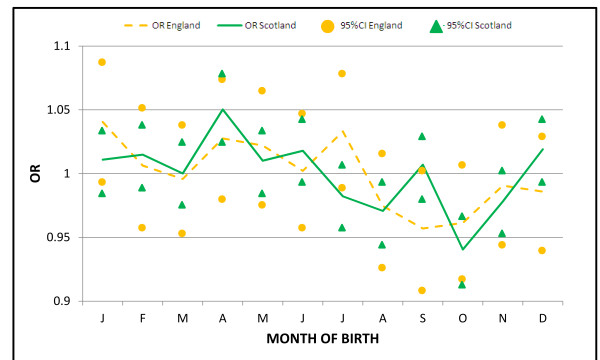
Odds ratio distribution based on month of birth in England and Scotland. The highest and lowest odds ratios are observed in Scotland but 95%CI substantially overlap.